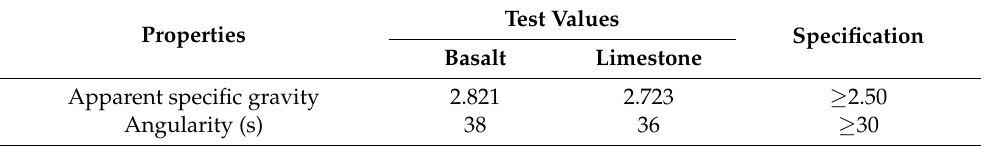
Table 3. Properties of the two fine aggregates.